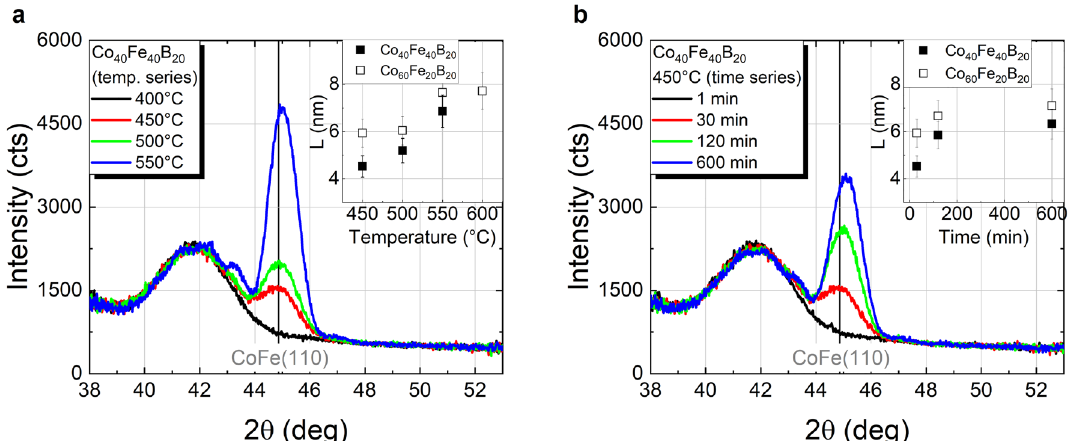
Figure 1. XRD θ -2 θ scans of Co 40 Fe 40 B 20 with a Ta capping layer furnace annealed for 30 min at temperatures in the range from 400 °C to 550 °C ( a ), and at 450 °C for different annealing durations ( b ). The vertical coherence lengths determined from the CoFe(110) reflex for both Co–Fe compositions are shown in the